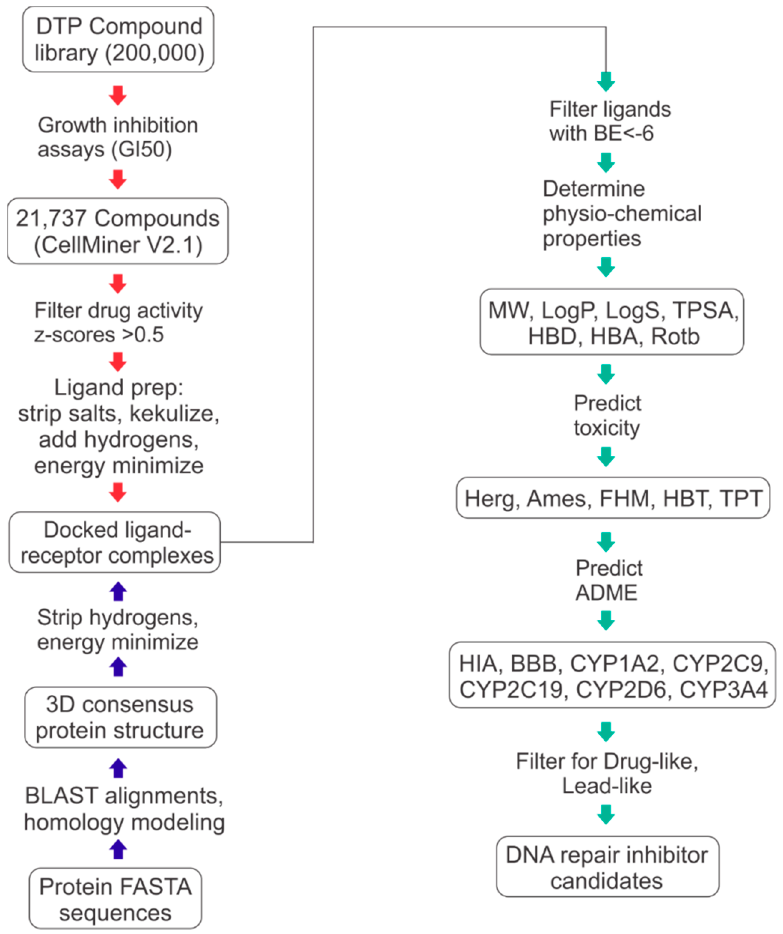
Figure 6. Workflow for ligand-receptor docking and drug- and lead-like hit identification.